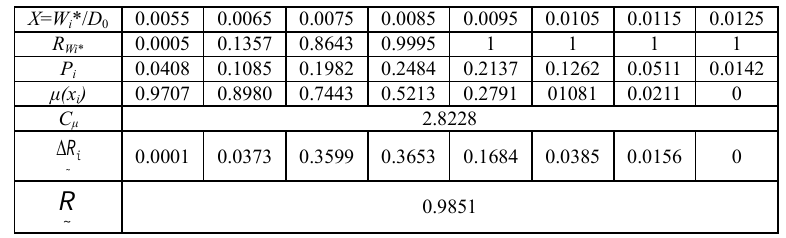
Table 3. Fuzzy reliability computation in interval with middle